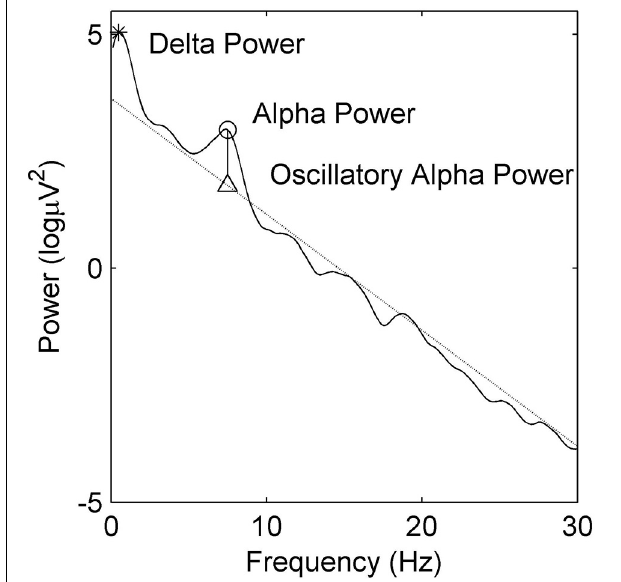
FIGURE 1 | Example power spectral density estimate showing absolute delta ( ∗ ) and alpha ( ◦ ) power. Oscillatory alpha power is the difference between maximal alpha power ( ◦ ) and the alpha power at the linear regression estimate ( (cid:3)